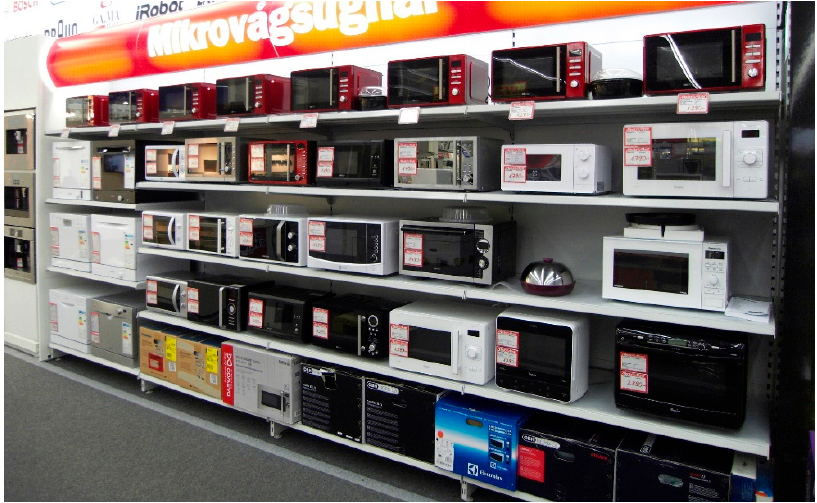
Figure 4. A retail shop of microwave oven. (Source: https://upload.wikimedia.org/wikipedia/commons/7/7e/Microwave_ovens%2C_Media_Markt%2C_Svagertorp%2C_Malmo.JPG, accessed on 26 December 2021).